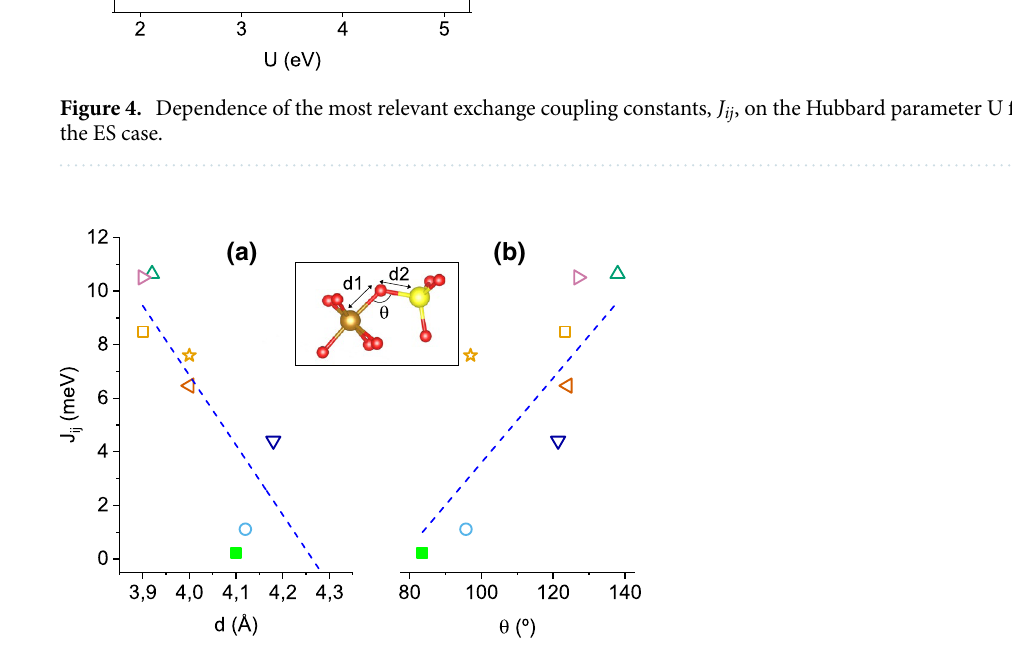
Figure 5. Dependence of the exchange constants strength, J ij , on: ( a ) the total Fe–O–Fe bond distance, d = d 1 + d 2 , and, ( b ) the super-exchange Fe–O–Fe angle θ (see inset). Each exchange constant is represented by the same symbol as that used in Fig. 4, while all values correspond to the ES and U = 3 eV case. In both plots the blue dashed line is a guide to the